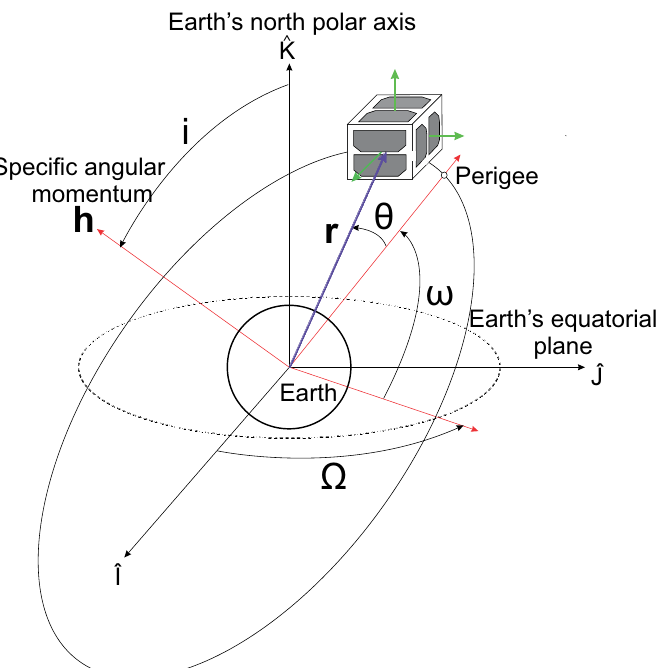
Figure 2. The orbit and position of a